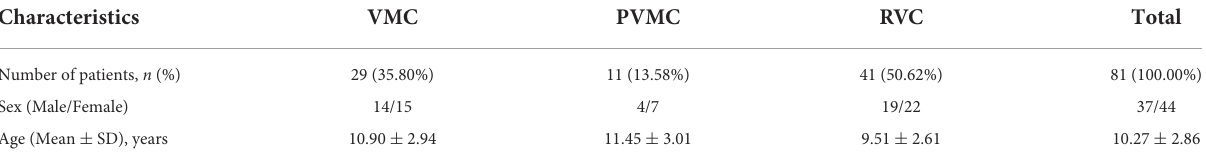
TABLE 1 Baseline data of the three groups.